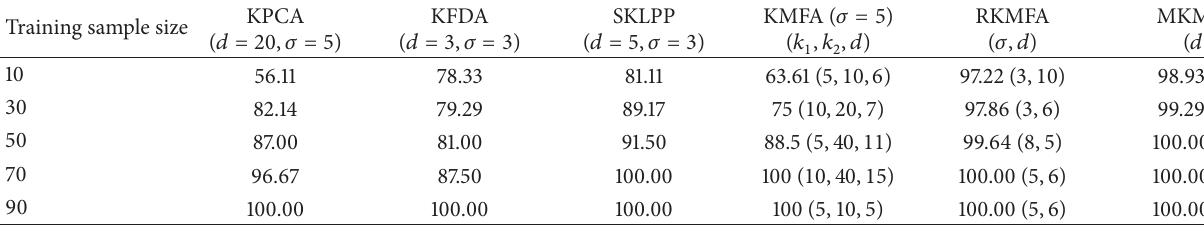
Table 3: The average recognition rates (%) of KNN for various training sample sizes each class. Training sample size